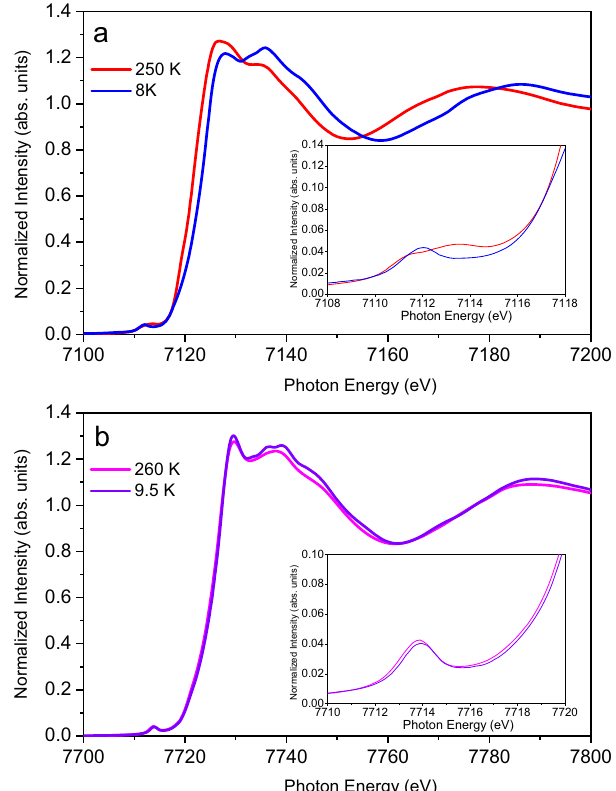
Fig. 5 XAS of the [FeCo] crystals. a Temperature-dependent Fe K-edge X- ray absorption spectroscopy (XAS) data for 1(PF 6 ) 3 . Inset- Fe pre-edge XAS data. b Co K-edge XAS data. Inset- Co pre-edge XAS data. NATURE COMMUNICATIONS| (2021) 12:4836